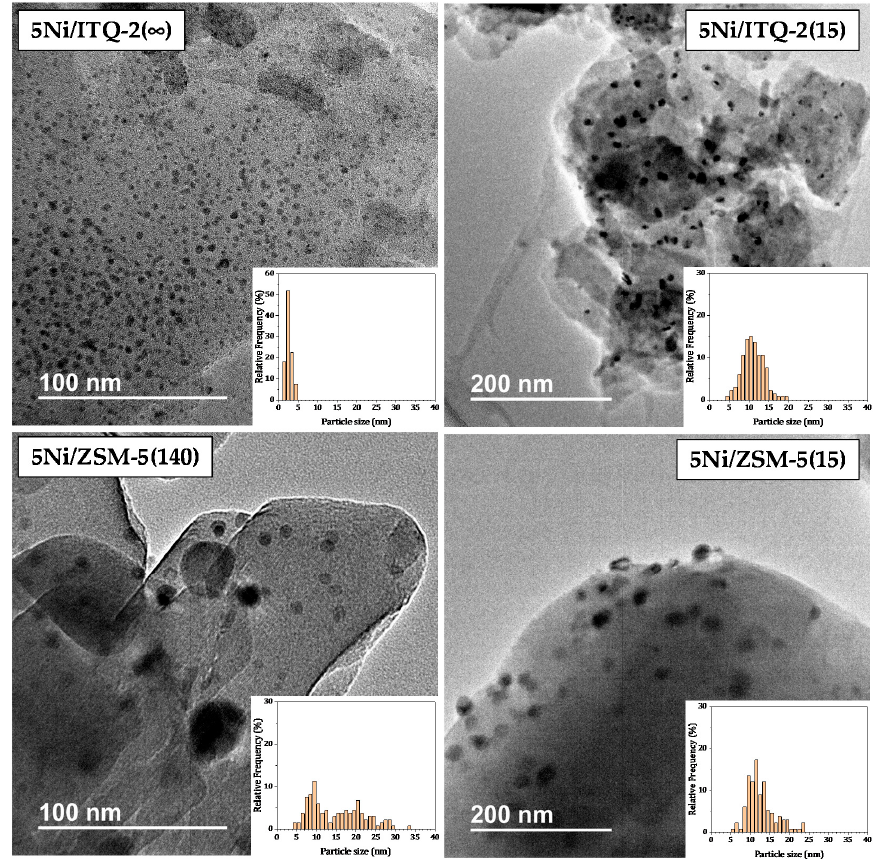
Figure 6. High-resolution transmission electron microscopy (HR-TEM) images and Ni 0 particle size distribution of the 5 wt.% Ni catalyst supported on ITQ-2 and ZSM-5 with di ff erent Si / Al ratios. Images obtained after the methanation